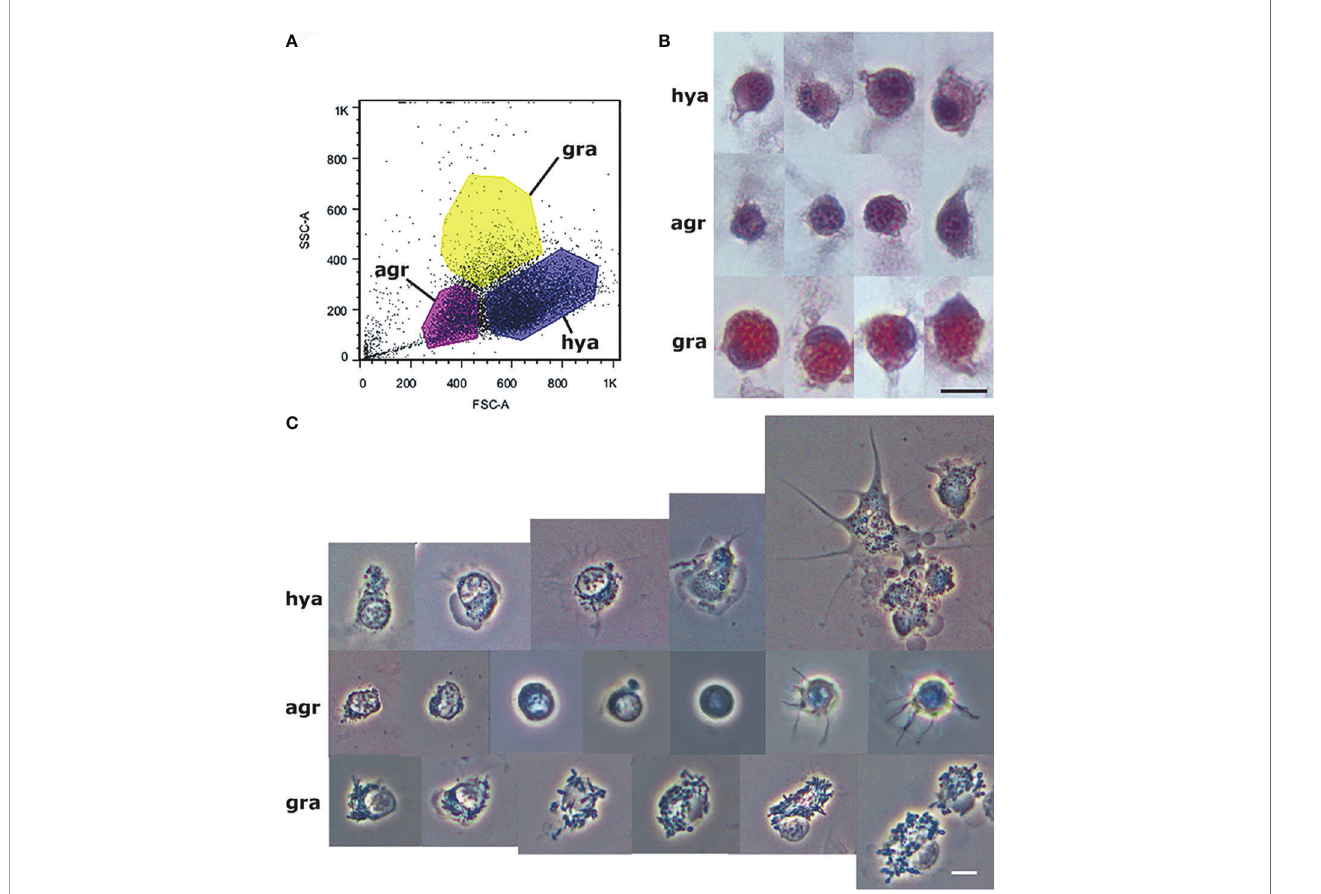
FIGURE 1 | Circulating hemocyte populations of P. canaliculata and their separation by fl ow cytometry. (A) Flow cytometry (dot plot of size vs. complexity-granularity) of a representative blood sample indicating the sorted areas where either agranulocytes, granulocytes and hyalinocytes were predominant. (B) Examples of hyalinocytes, agranulocytes and granulocytes in hemolymph smears (hematoxylin-eosin stain). (C) Examples of living hyalinocytes, agranulocytes and granulocytes attached onto a glass slide (phase contrast). GR, agranulocytes; GRA, granulocytes; HYA, hyalinocytes. Scale bars represent 5 m m. From